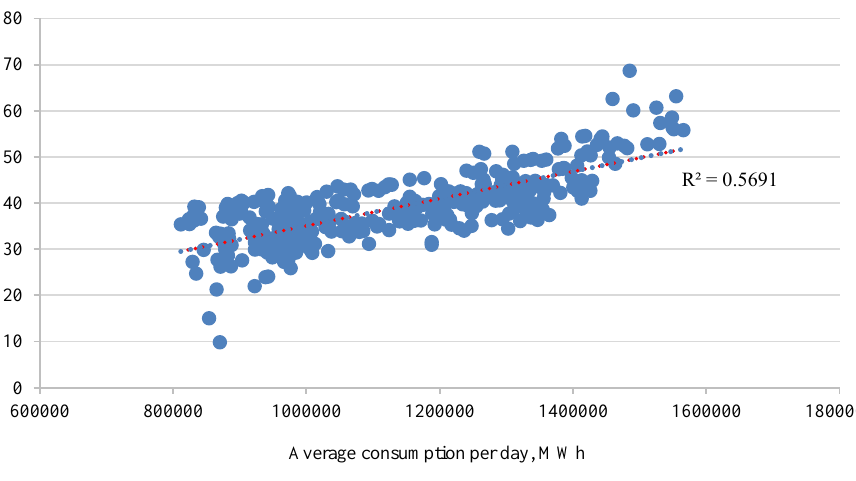
Fig. 5. Correlation between wind power share in total consumption (demand) and power market price on hourly basis in Denmark during 2019 (Data source: Nord Pool Spot). Furthermore, analysis performed on the daily power consumption data, showed that the power wholesale prices has a far stronger positive correlation with electricity consumption (Fig. 6), and there were very few deviations from the overall trend – the highest market prices were reached only in periods with a relatively high power demand, while the lower market prices – only in periods with the low power demand.